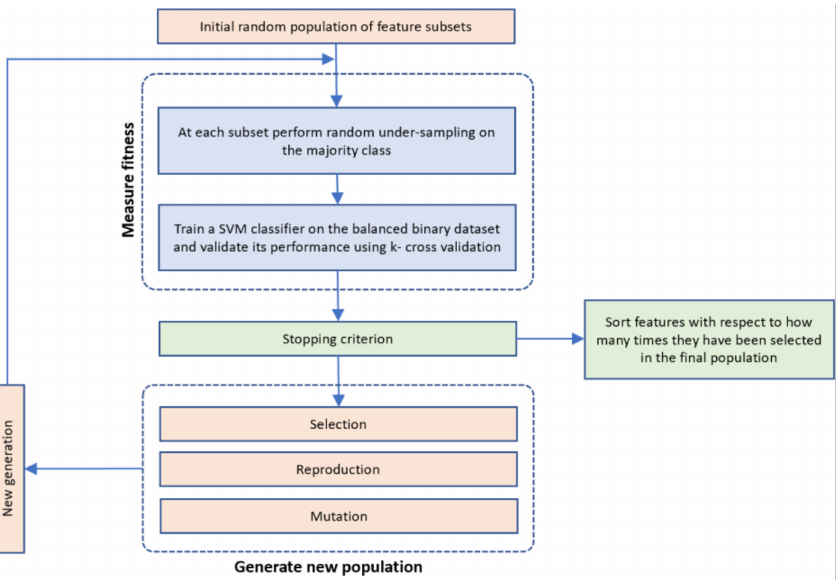
Figure 2. The proposed GenWrapper feature selection (FS) methodology that includes all the involved processing steps: (i) generation of the initial population; (ii) fitness measurement approach; (iii) stopping criterion; (iv) evolution mechanisms and (v) final feature ranking after the termination of the genetic algorithm